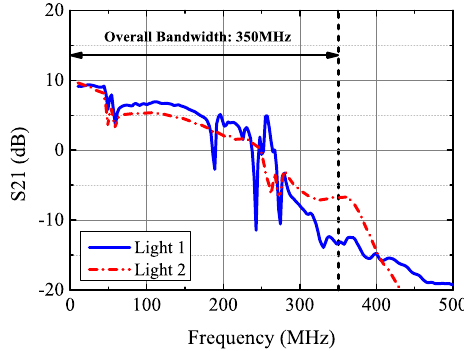
Figure 3. The measured S21 transfer response from each light to the receiver at 1 m.